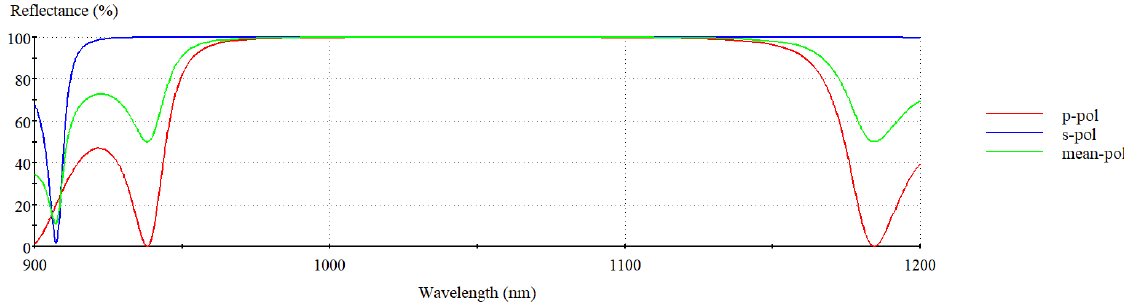
Figure 5. MDG diffraction efficiency at different wavelengths. To date, three-layer gratings have greater diffraction efficiency than single-layer grat- ings. We discover that the diffraction performance may still be enhanced. Thus, in our work, an interlayer material is applied to the rectangular grating, as shown in Figure 6. The material must be different from SiO 2 and have a high laser-induced damage thresh- old. With a reasonably high LDT of 2.52 J/cm 2 [22], a high refractive index Al 2 O 3 material is a good candidate for interlayer grating design. We merely alter the position and thick- ness of h 2 in this case. The overall thickness of the grating is still 2130 nm, as shown in the above results. 1060